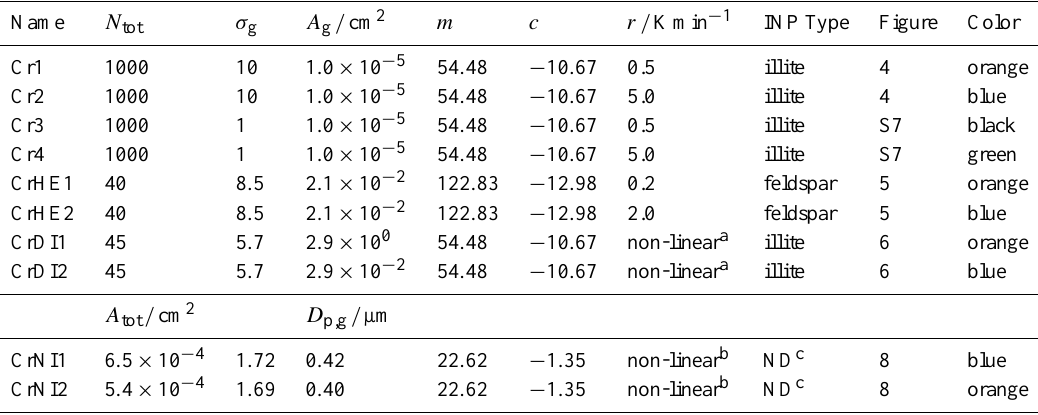
Table 2. Summary of parameters used in cooling-rate model simulations.